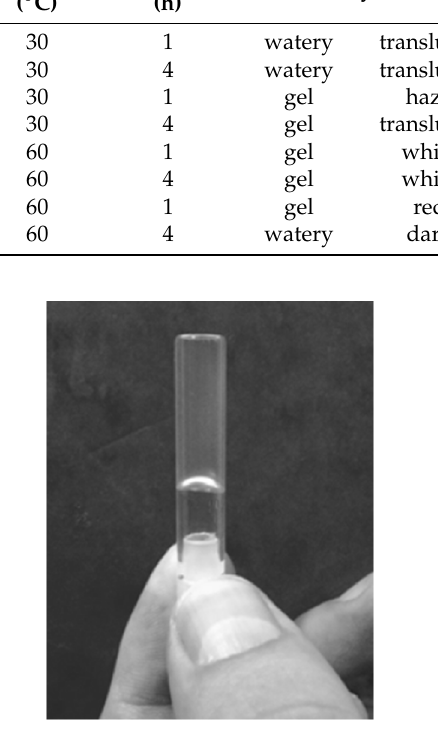
Figure 1. Photograph of the translucent and stable gel of ivory nut nanocellulose obtained from the endosperm of crude parenchyma treated with 8 M H 2 SO 4 for 4 h at 30 °C and ultrasonicated (treatment 4 in Table 1).